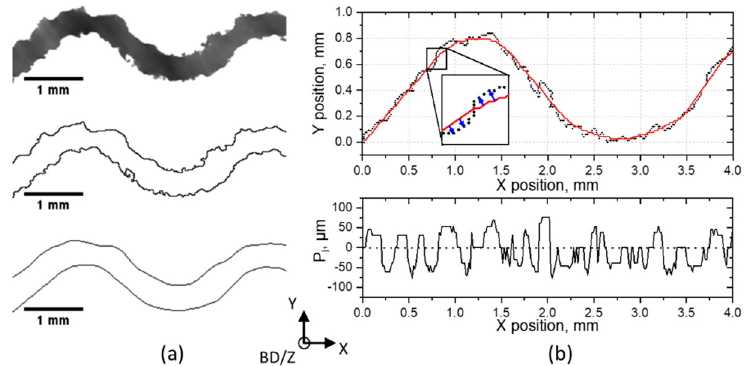
Figure 11. Evaluation of the surface roughness. ( a ) A 2D cross-section extracted from the vertical wall of 2 × 04 specimen (top), the profiles of both sides of the wall (middle), the profiles after low-pass filtering (bottom); ( b ) example showing the original (black points) and filtered profiles (contin- uous red line) and the resulting roughness profile (bottom). BD indicates the build direction (normal to the layer surfaces).